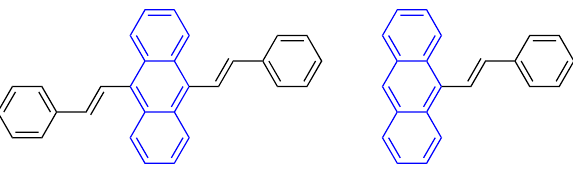
Figure 1. The structures of distyrylanthracene ( left ) and mono-functionalize anthracene ( right ).